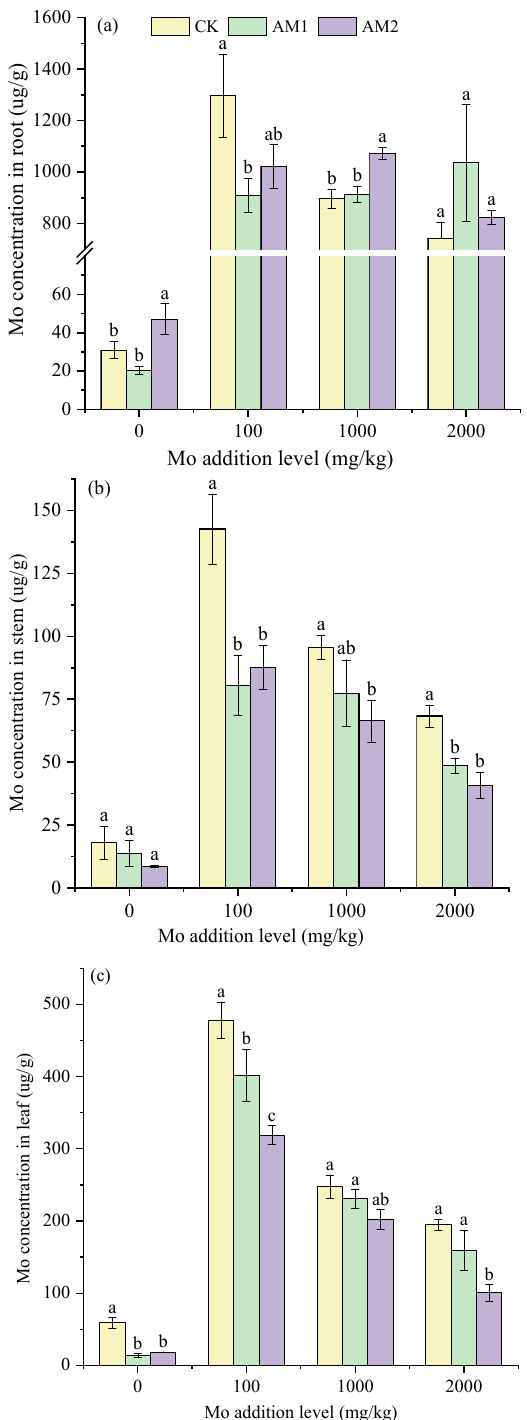
Figure 2. Mo concentration in root ( a ), stems, ( b ) and leaves ( c ) of maize under different levels of Mo addition. Different lowercase letters above the bars indicate significant differences under the different inoculation conditions at the same level of Mo addition, determined using a one-way ANOVA followed by Duncan’s multiple range test ( p < 0.05).